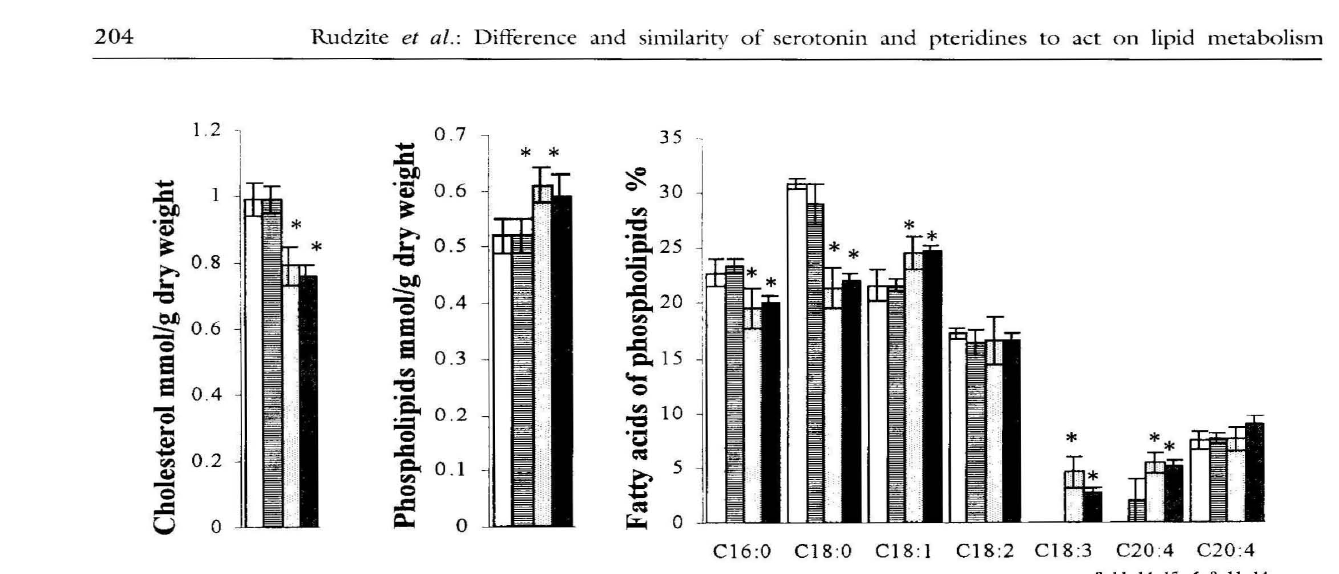
Figure 4. Concentration (mean ± S.D .) of cholesterol and phospholipids, as well as fatty acid content (in percent: mean ± S.D.) of phospholipids in controls (open bars), in samples with 10 nmoljg wet weight (striped bars) iproniasid, an in hibitor of amine: O 2 oxidoreductase; in samples with 0.2 nmoljg wet weight scrotonin togethcr with 10 nmoljg wct weight iproniasid (dotted bars) and in samples with 2.0 nmoljg wct weight serotonin together with 10 nmoljg wet weight iproniasid (hatched bars). Samples of rat liver tissue homogenatcs were used to test for phospholipid biosynthesis in vitro. Incubation medium: Krebs-Ringcr-phosphatc buffer, containing 0.3% albumin (pH=7.4), fatty acid mixture and glycerol. Samples were incubated twice for 4 h at 37"C. *The changes are statistically significant (p < 0.05-p < 0.001 ).